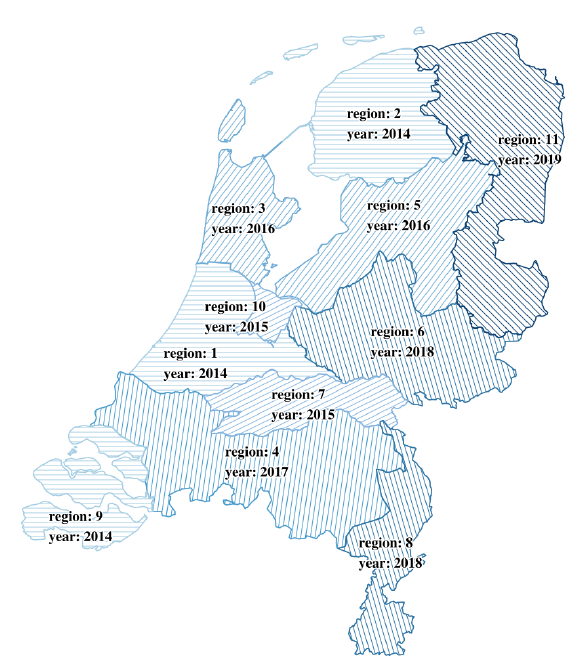
Figure 5 . The acquisition years and regions of the input point cloud.